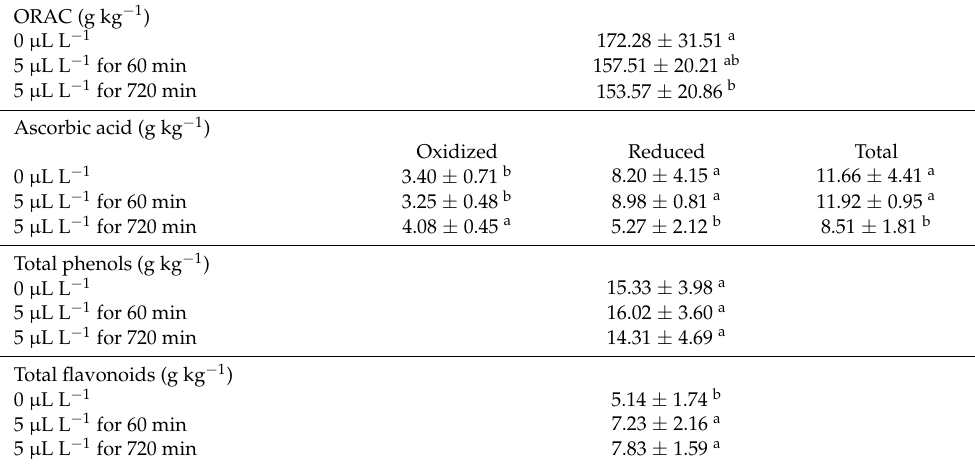
Table 1. Oxygen radical absorbance capacity (ORAC, Trolox equivalents), and ascorbic acid (oxidized, reduced, total), total phenols (gallic acid equivalents), total flavonoids (quercetin equivalents), rutin (sinigrin equivalents), and chlorogenic acid (sinigrin equivalents) contents in broccoli florets exposed to